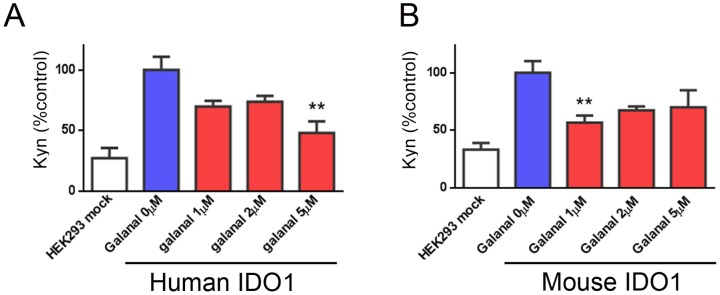
Effect of galanal on IDO1 activity in different cell species.HEK 293 cells transfected with human IDO1 (A) or mouse IDO1 (B) were treated with various concentrations (1-5 µM) of galanal for 48 hrs. Data are mean ± SD (n = 3). **P<0.01.